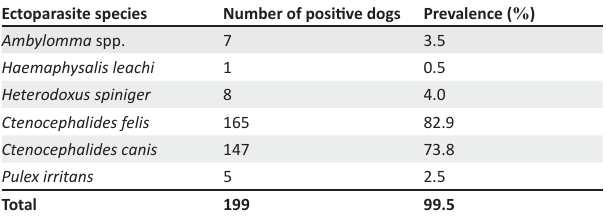
TABLE 1: Overall prevalence of ectoparasites on examined dogs ( n = 200) in Hawassa.